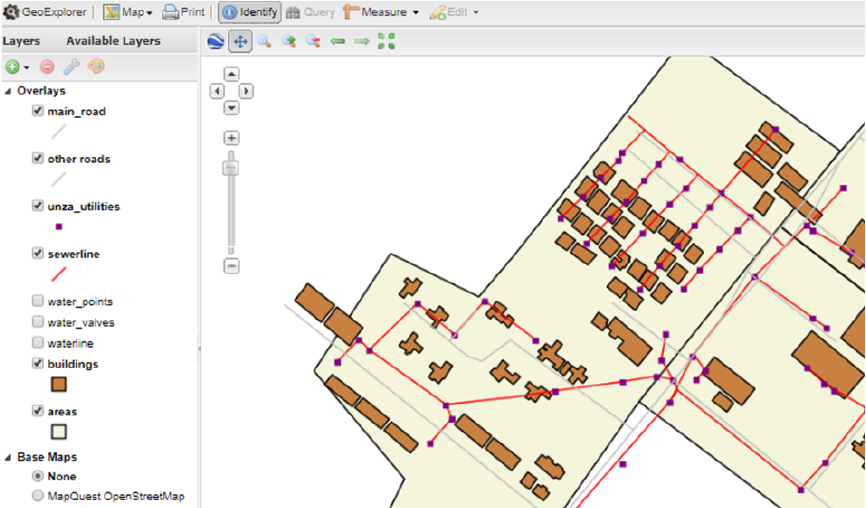
Fig. 13. Water and Sewer Network layers in